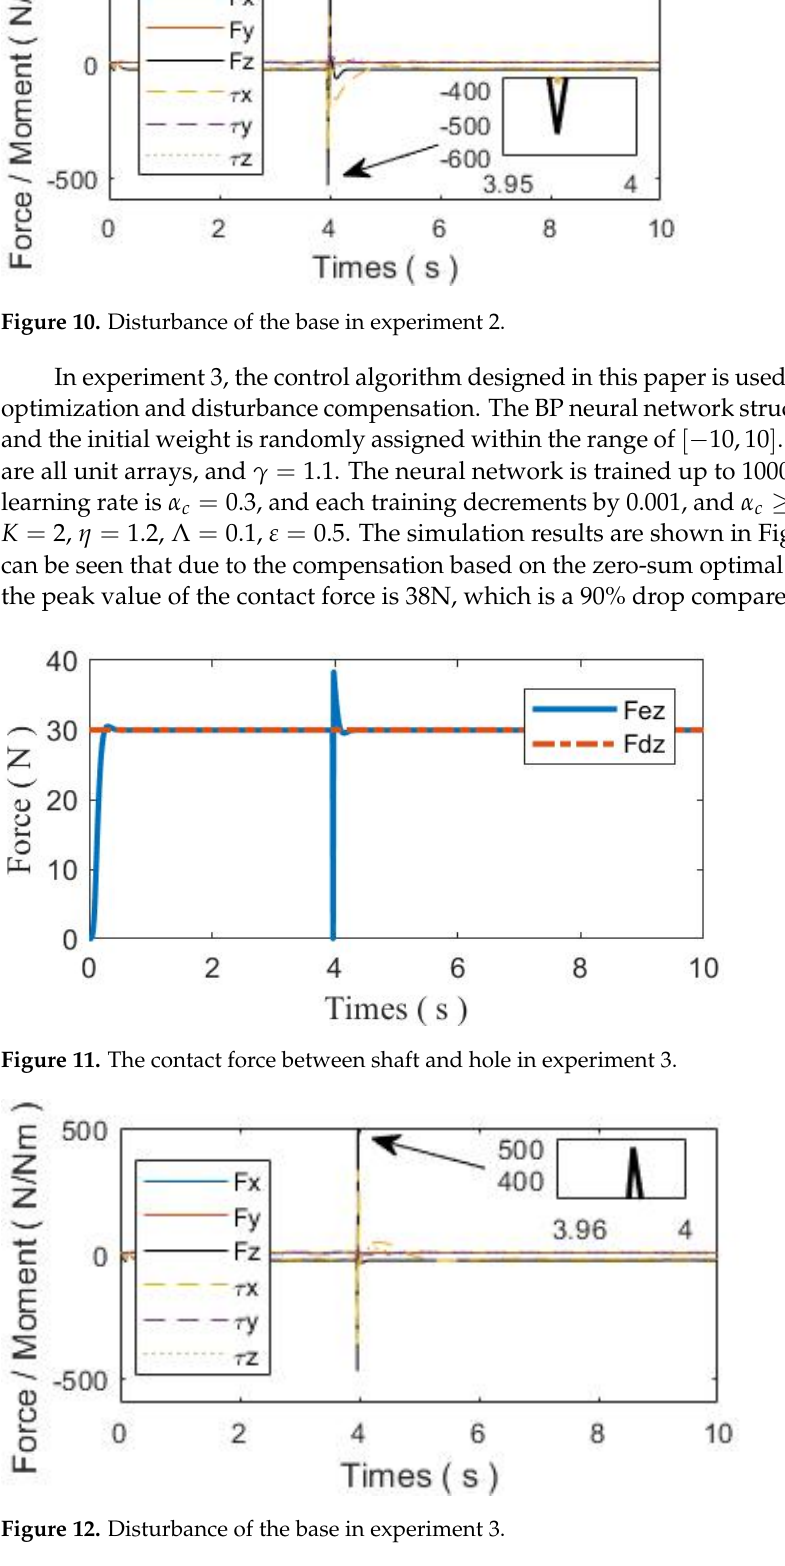
Figure 9. The contact force between shaft and hole in experiment 2.